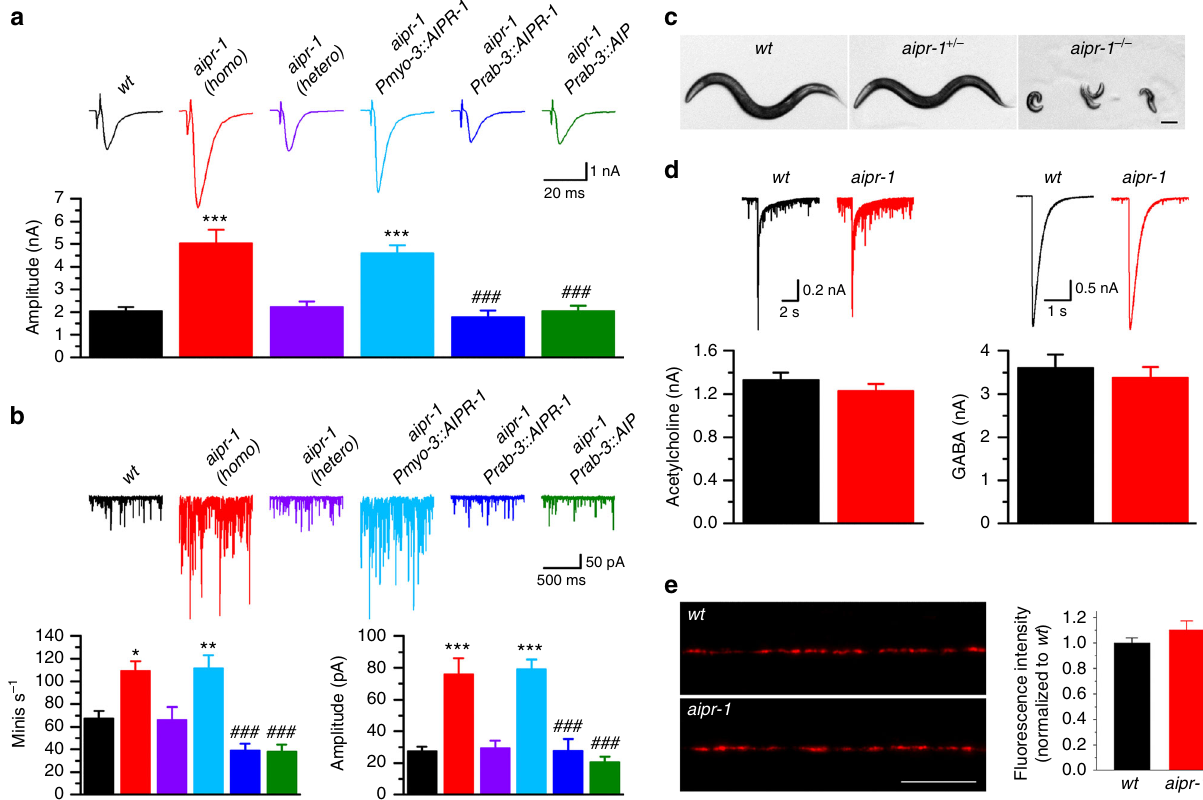
Fig. 2 Augmented synaptic transmission in aipr-1(zw86). a , b Comparison of evoked currents a and spontaneous miniature currents (minis) b at the neuromuscular junction among wild type ( wt ) ( n = 7), homozygous aipr-1(zw86) ( n = 7), heterozygous aipr-1(zw86) ( n = 7), and aipr-1(zw86) rescued either in neurons (P rab-3:: AIRP-1, n = 7; P rab-3::AIP , n = 9) or body-wall muscle cells (P myo-3::AIPR-1 , n = 7). c Homozygous aipr-1 knockout ( aipr-1 -/- ) worms arrest at early larval stages. The knockout results from a 2 bp deletion in the fi rst exon of aipr-1 . Scale bar, 100 µ m. d Comparison of muscle inward current in response to exogenous acetylcholine (100 µ M) and GABA (100 µ M) between wt (ACh, n = 7; GABA, n = 7) and aipr-1(zw86) (ACh, n = 8; GABA, n = 8). Data are shown as mean ± SEM. * p < 0.05, ** p < 0.01, *** p < 0.001 compared with wt ; ### p < 0.001 compared with aipr-1(zw86)